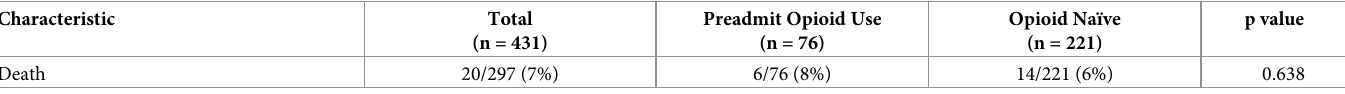
through each of these timepoints. Generalized linear models with a logit function were used to examine odd of persistent opioid prescription 1, 6 and 12 months after discharge (Table 3). Testing collinearity using variance inflation factors (VIF) indicated no problematic amount of collinearity among the independent variables (all VIF < 5). Preadmission opioid use was associated with increased odds of being prescribed opioids at 1 (OR 8.7, 95% CI 3.2–27.1,